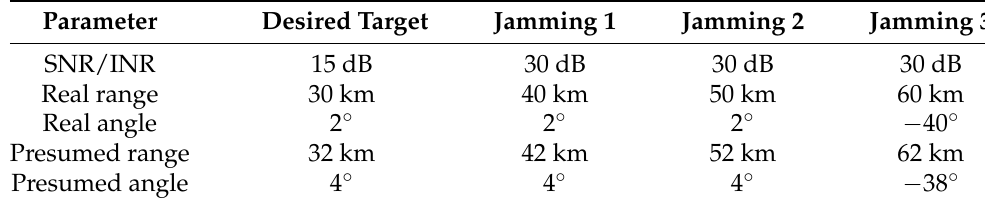
Table 2. Desired target and deceptive jamming